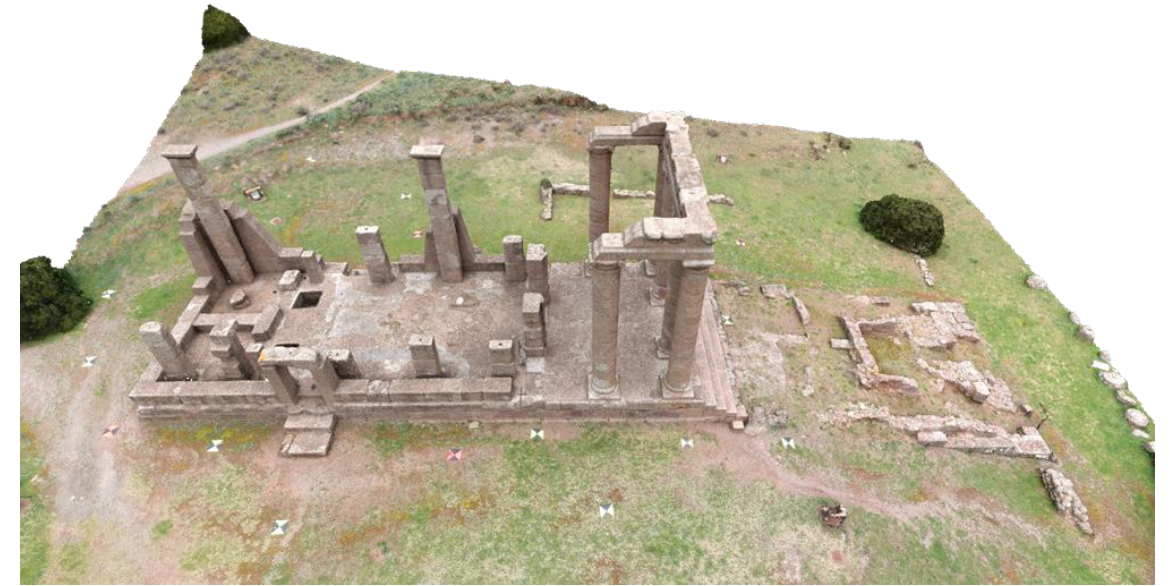
Figure 13. 3D rendering of the final